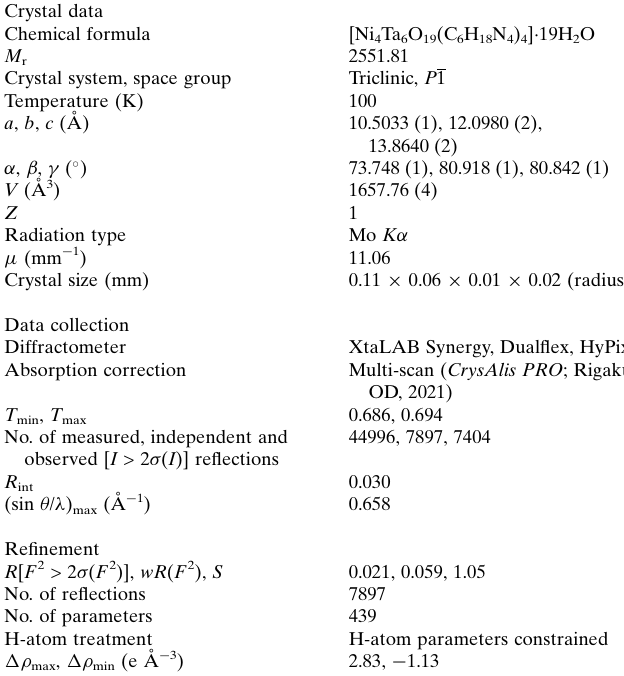
Table 3 Experimental details. Crystal data Chemical